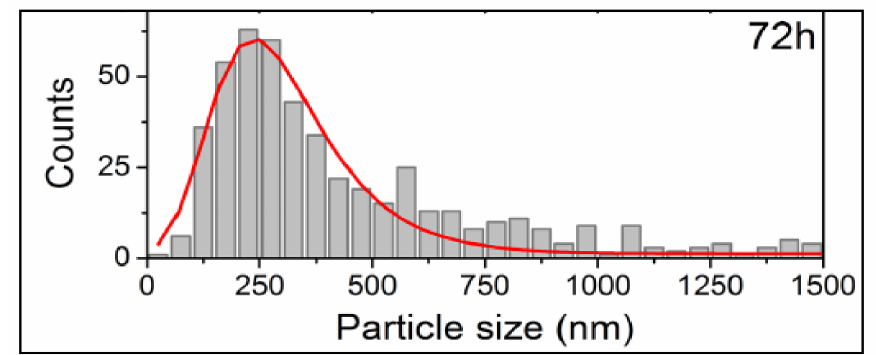
Figure 30. Particle size of 72 h ball-milled biochar derived from SCB [121].